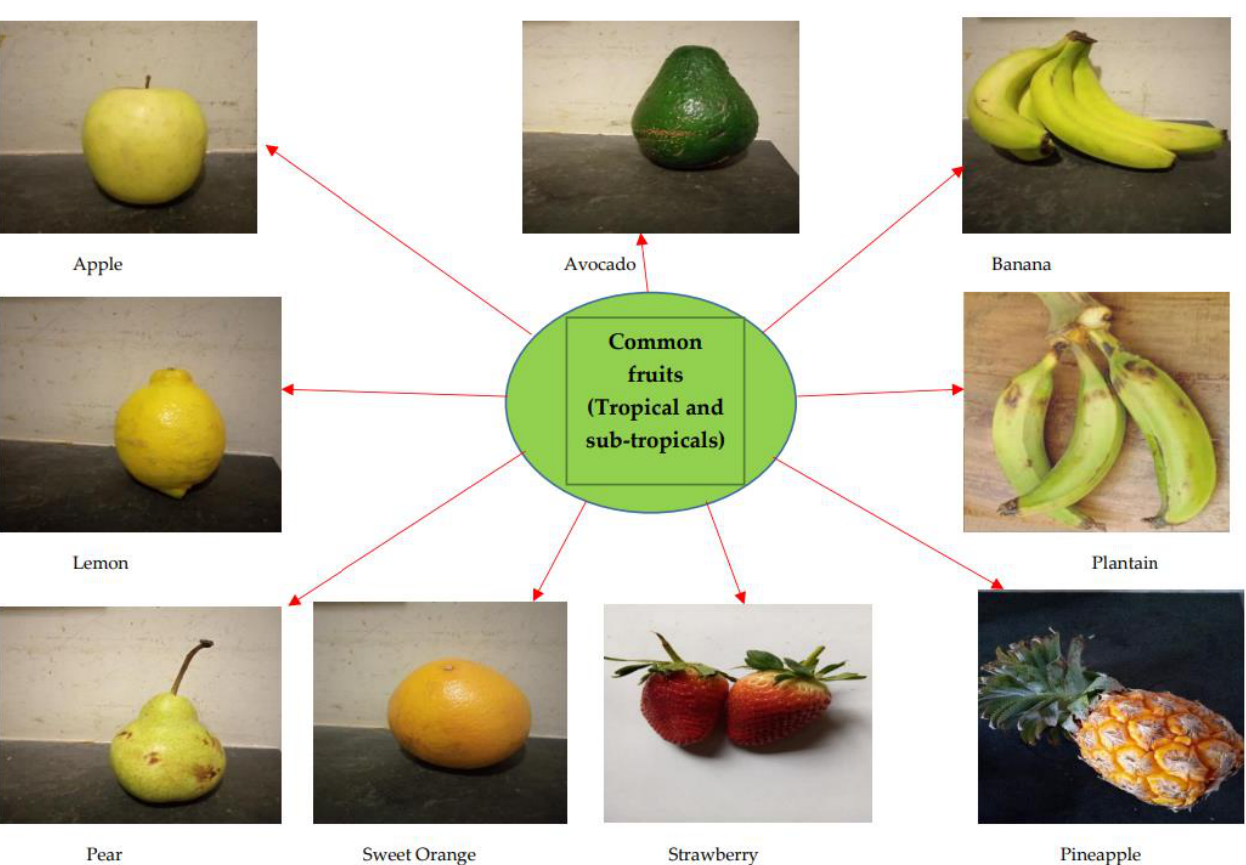
Figure 2. Commonly consumed fruits with bioactive capacities; including Banana and Plantain. Date palm fruits ( Phoenix dactylifera ) have been reported in studies for their potential biological capacity in nephroprotective, hepatoprotective, and anticancer activity [35–37]. Recently, the inhibitory effect of avocado juice against trypsin aggregation has been re- ported: a formation process associated with several neurological diseases [38]. Similarly, other reports identified the beneficial role of berries (blackberry and blueberry) with regards to the obstruction of the central nervous system and cognitive deficit [39,40]. The cactus pear ( Opuntia ficus-indica ) fruit has also been reported to have the biological capacity to modulate neuron excitation in a distributive manner across sectors of the brain [41]. Over time, a host of bioactive molecules cutting across nutritive and antinutritive factors, vitamins, minerals, and secondary metabolites have been screened, evaluated, and elucidated in several species and varieties of banana and plantain fruits, as shown in Table